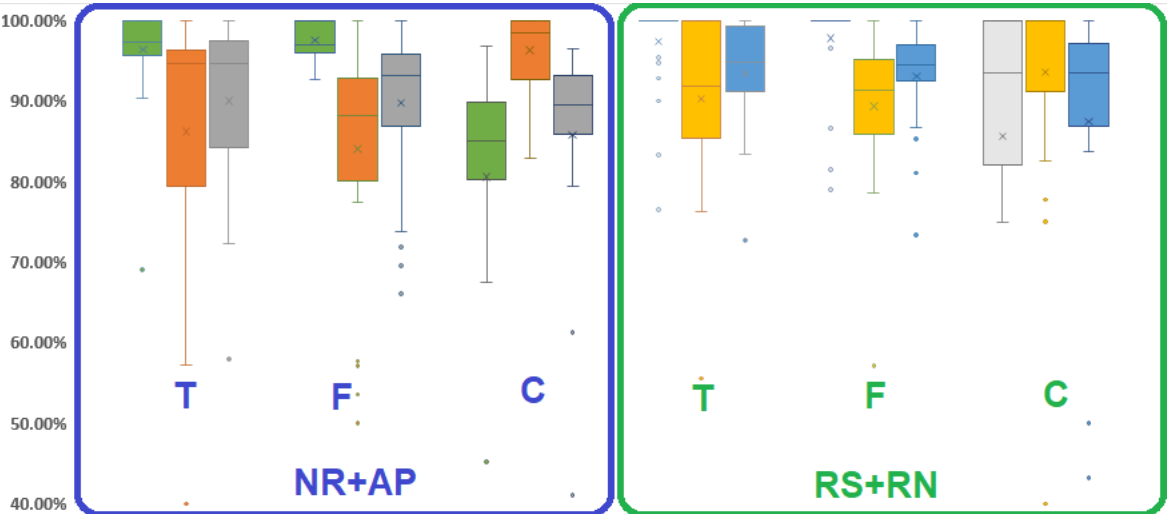
Figure 13. Influence of speech and noise on respiratory detection. Box plot (as box plot of Figure 12) for specificity (green and light gray boxes), sensitivity (orange and yellow boxes) and accuracy (dark gray and blue boxes) of temporal (T), frequency (F), and cardiac (C) detection domains, separated in NR+AP phases (in blue square) and RS + RN phases (in green